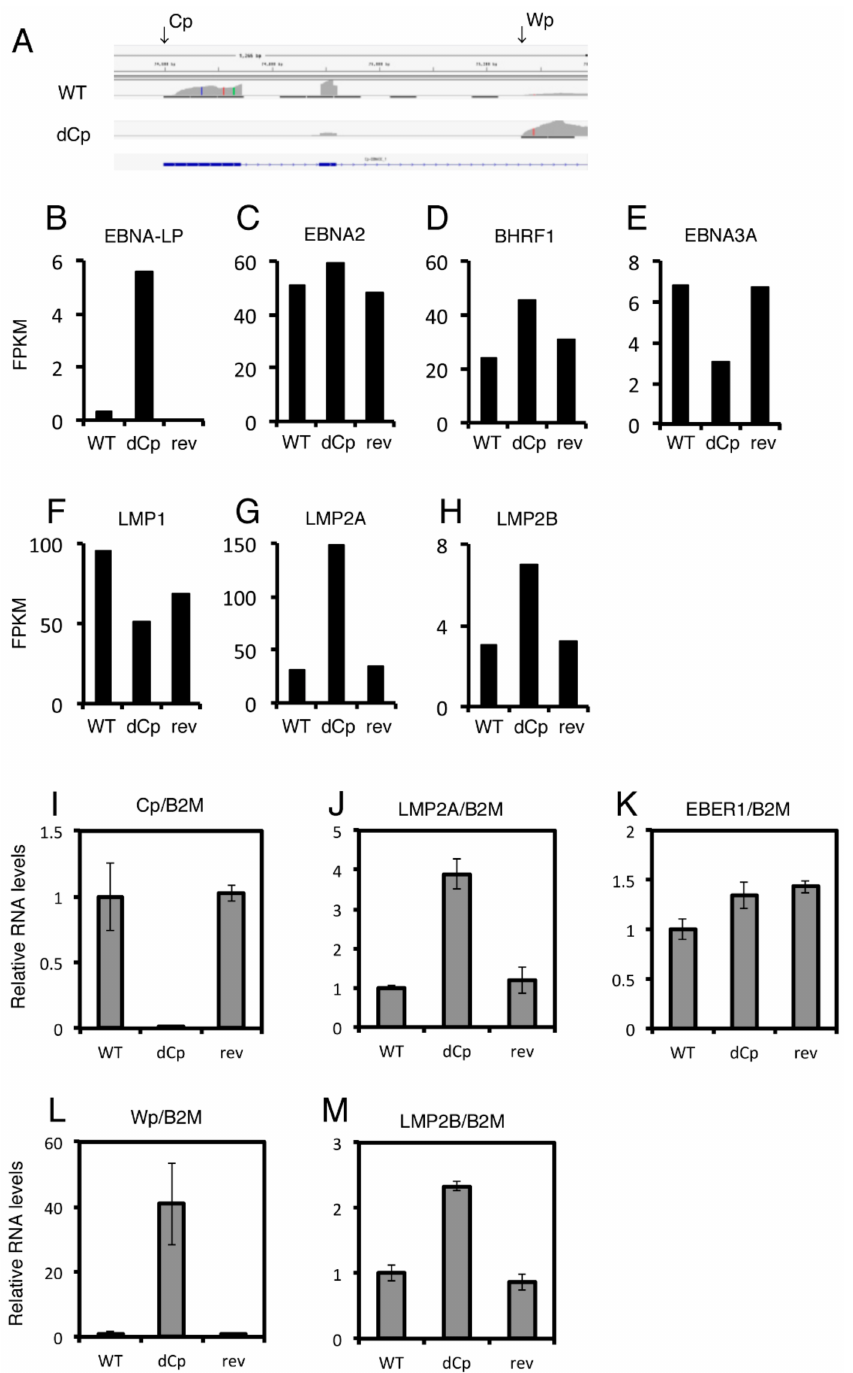
Figure 5. RNA sequencing (RNA-seq) and qRT–PCR of WT, dCp and rev virus-infected lymphoblas- toid cell lines (LCLs). ( A – H ) RNA-seq analysis of infected LCLs. ( A ) read mapping of transcripts aligned to the Cp/Wp region of EBV. ( B – H ) fragments per kilobase of exon per million reads mapped (FPKM) data of EBV genes are depicted. ( I – M ) qRT–PCR of the LCLs. Relative RNA levels were stan- dardized by β 2-microglobulin (B2M). The mean and standard deviation values of three independent experiments are